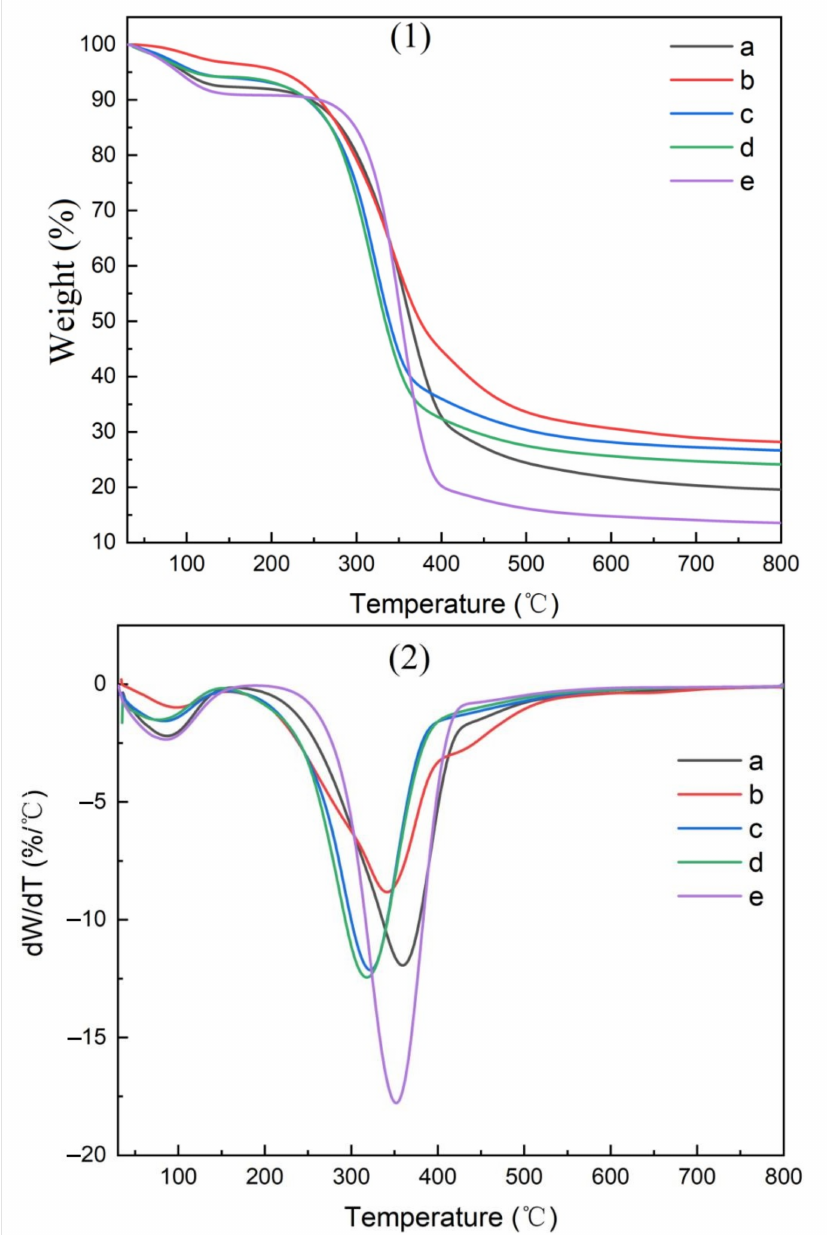
Figure 10. TG curves of materials used to produce CMCs derived from (a) pine wood, (b) bamboo culm, (c) pine needles, (d), bamboo leaves, or (e) hemp hurd, shown as thermogravimetric analysis ( 1 ) or differential thermogravimetric analysis ( 2